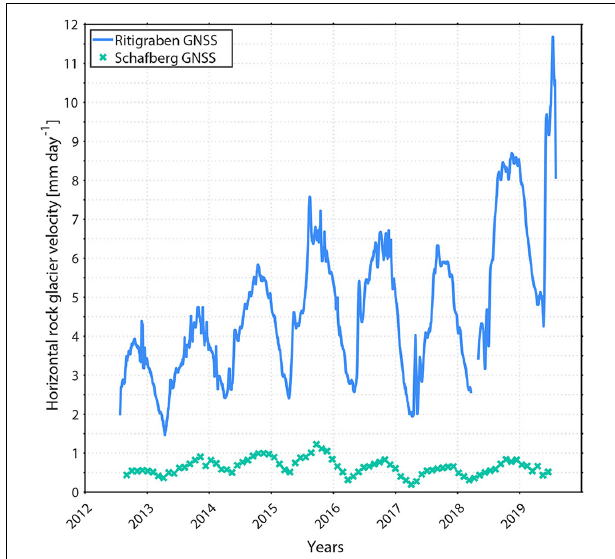
FIGURE 13 | Horizontal rock glacier velocities [mm day − 1 ] on the ice-rich rock glaciers Schafberg and Ritigraben from 2012 to 2019 derived from permanent GNSS observations. For Schafberg a 31-day moving mean and for the fast moving Ritigraben rock glacier an 11-day moving mean is shown (section “3.3.3 In-situ Global Navigation Satellite